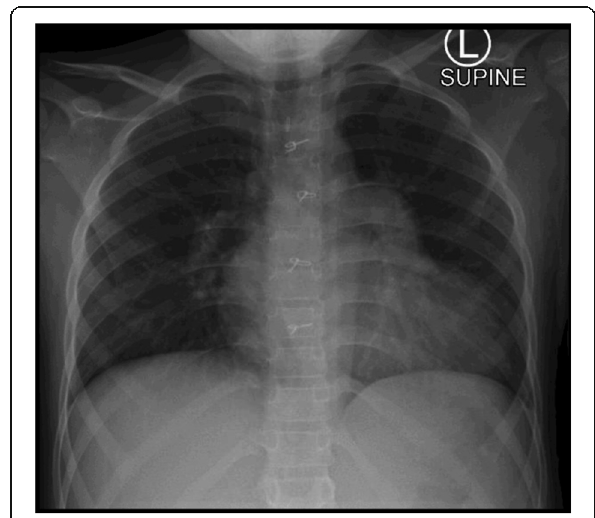
Fig. 2 Chest X-ray showing that the cardiac silhouette is enlarged with the prominence of the left pulmonary artery. The lung fields and the costophrenic angles are clear